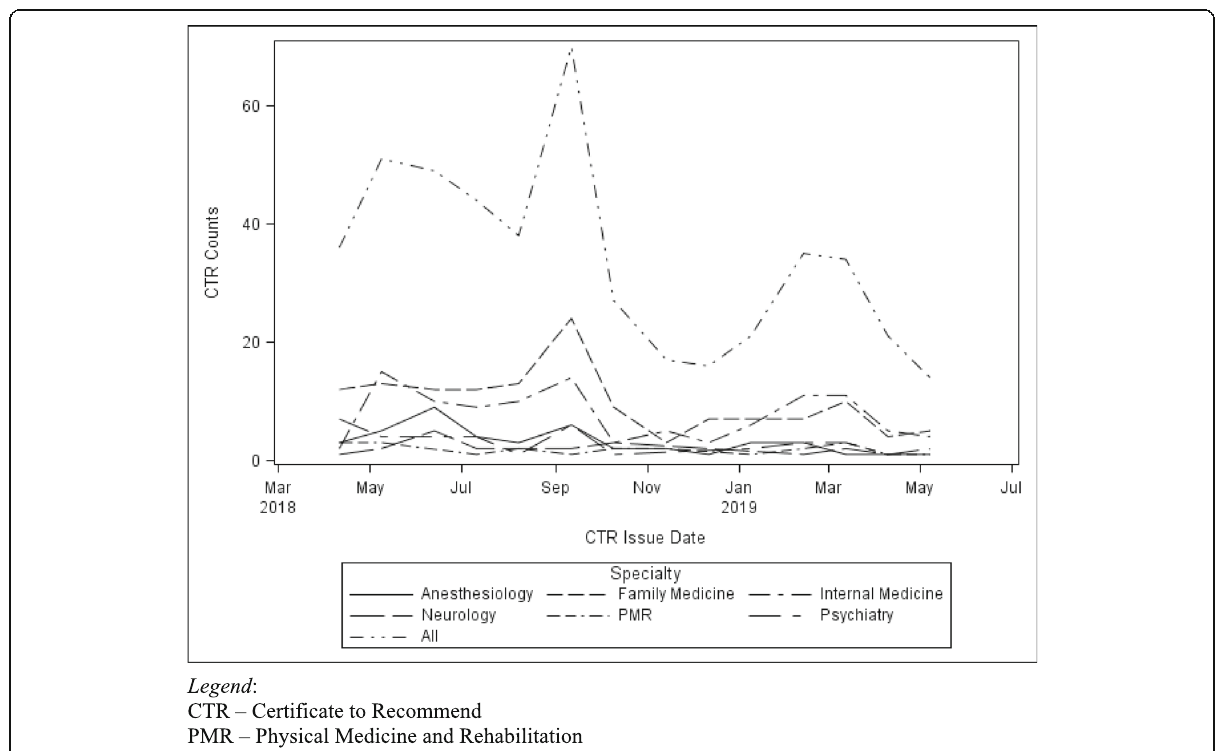
Fig. 1 Certificates to Recommend: Counts Per Month, Total and by Specialty. CTR – Certificate to Recommend. PMR – Physical Medicine and